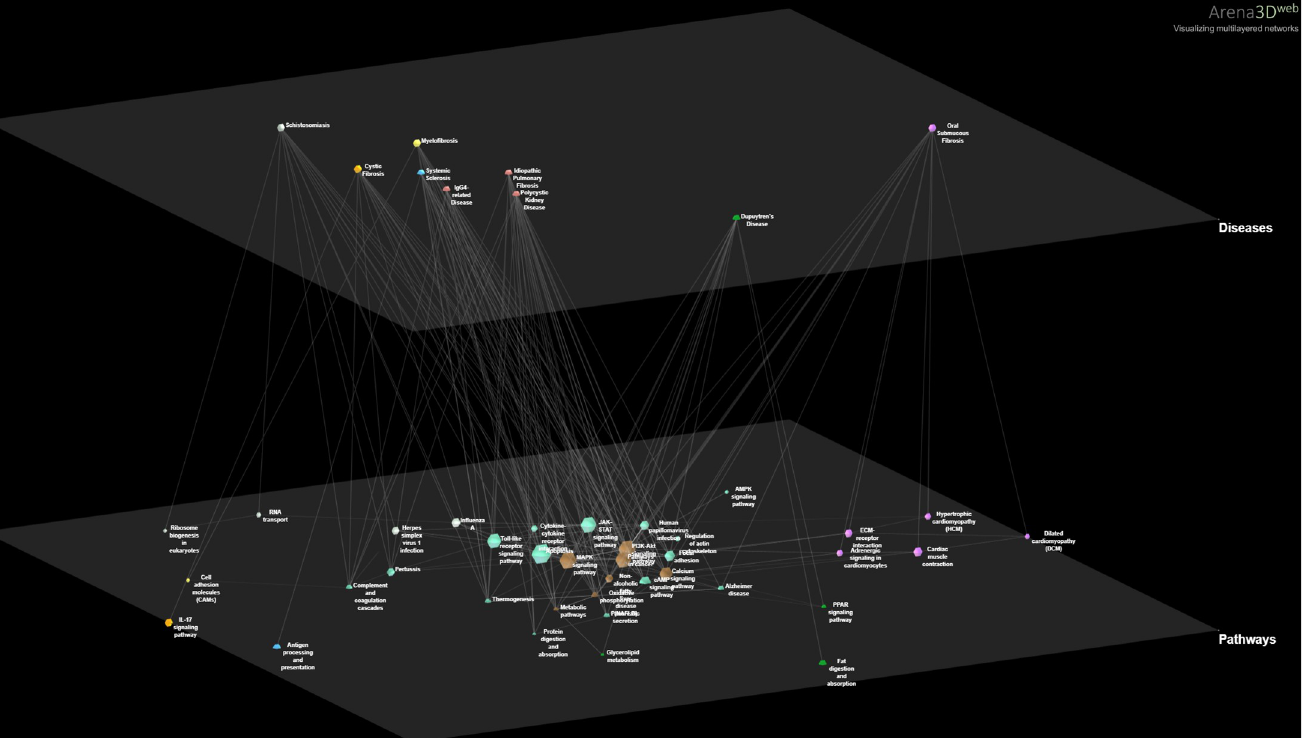
PLOS ONE | https://doi.org/10.1371/journal.pone.0249687 April 7, 2021 12 /